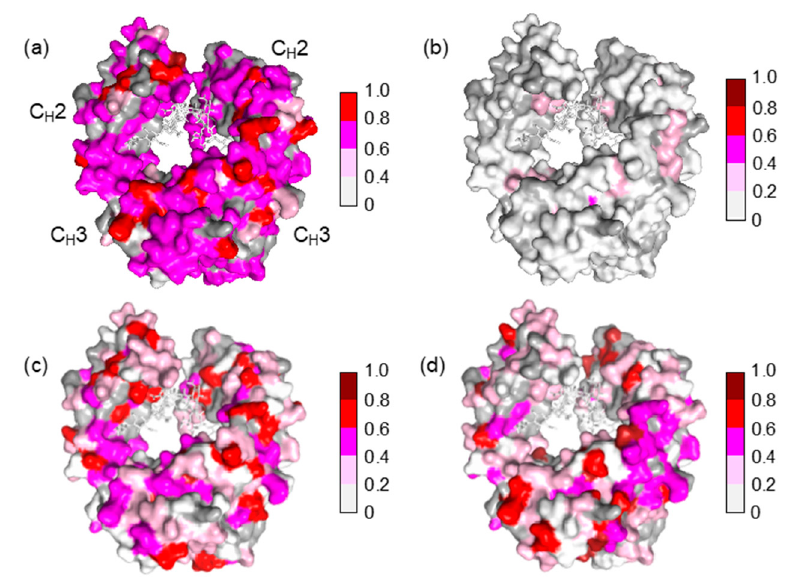
Figure 4. Mapping of the crystal structure of mouse IgG2b-Fc (PDB code: 2rgs) [30] with the observed spectral perturbations by addition of ( a ) human serum; ( b ) HAS; ( c ) human polyclonal IgG; and ( d ) the Fab fragment derived from human serum polyclonal IgG. The attenuation in intensity of the HSQC cross peaks is calculated as described in Figure 3. The proline residues and the residues whose 1 H- 15 N HSQC peaks could not be observed as probe because of broadening and/or overlapping are shown in gray. The N-glycans are shown as stick models. The molecular graphics were generated using PyMOL [31].